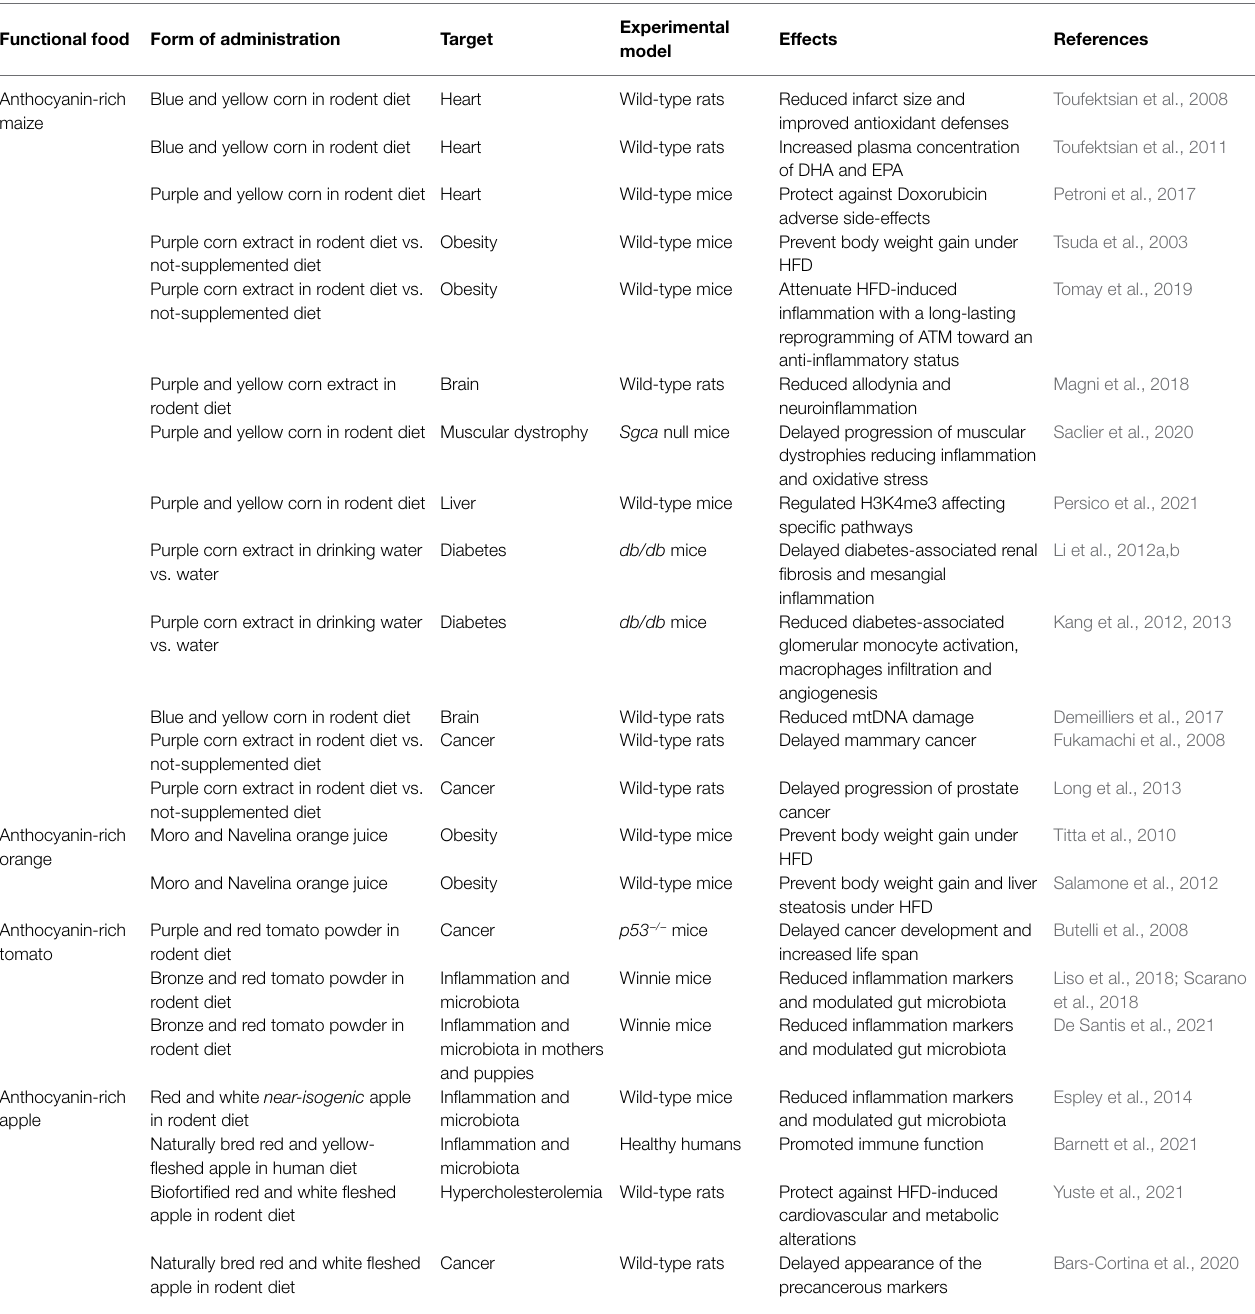
TABLE 1 | Health effects of anthocyanin-containing foods against anthocyanin-free comparators. Functional food Form of